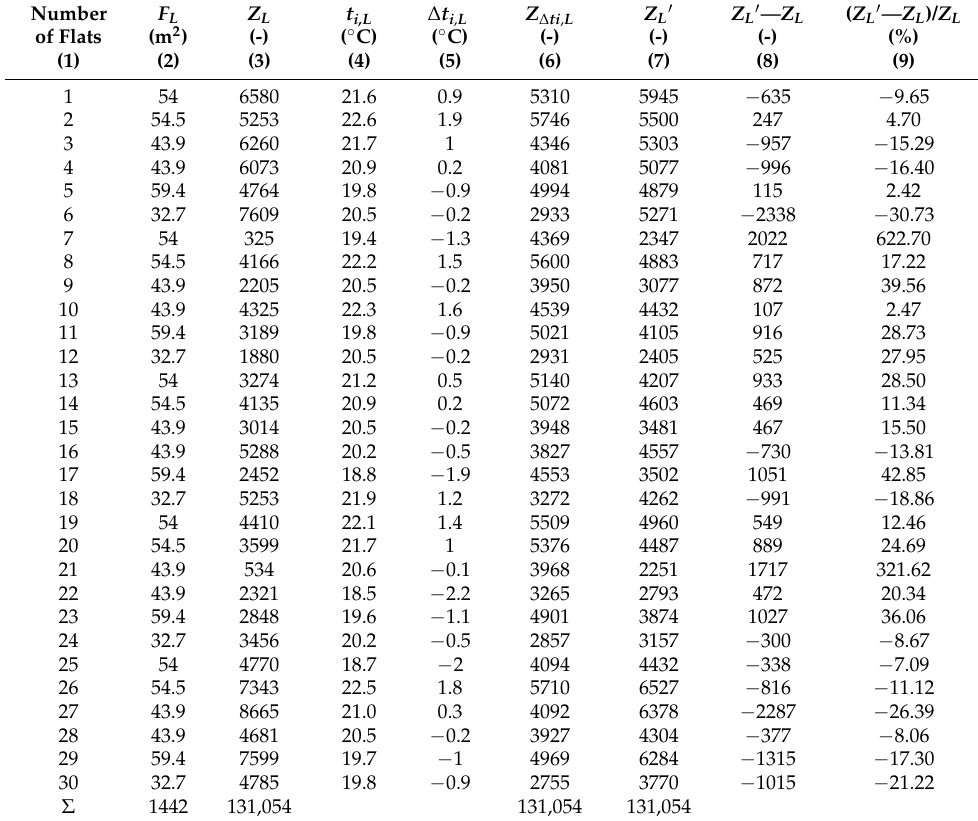
Table 2. Data and results of the variable heat costs allocation in the analysed building using method 4 ( scheme A ) without taking into account the LCF